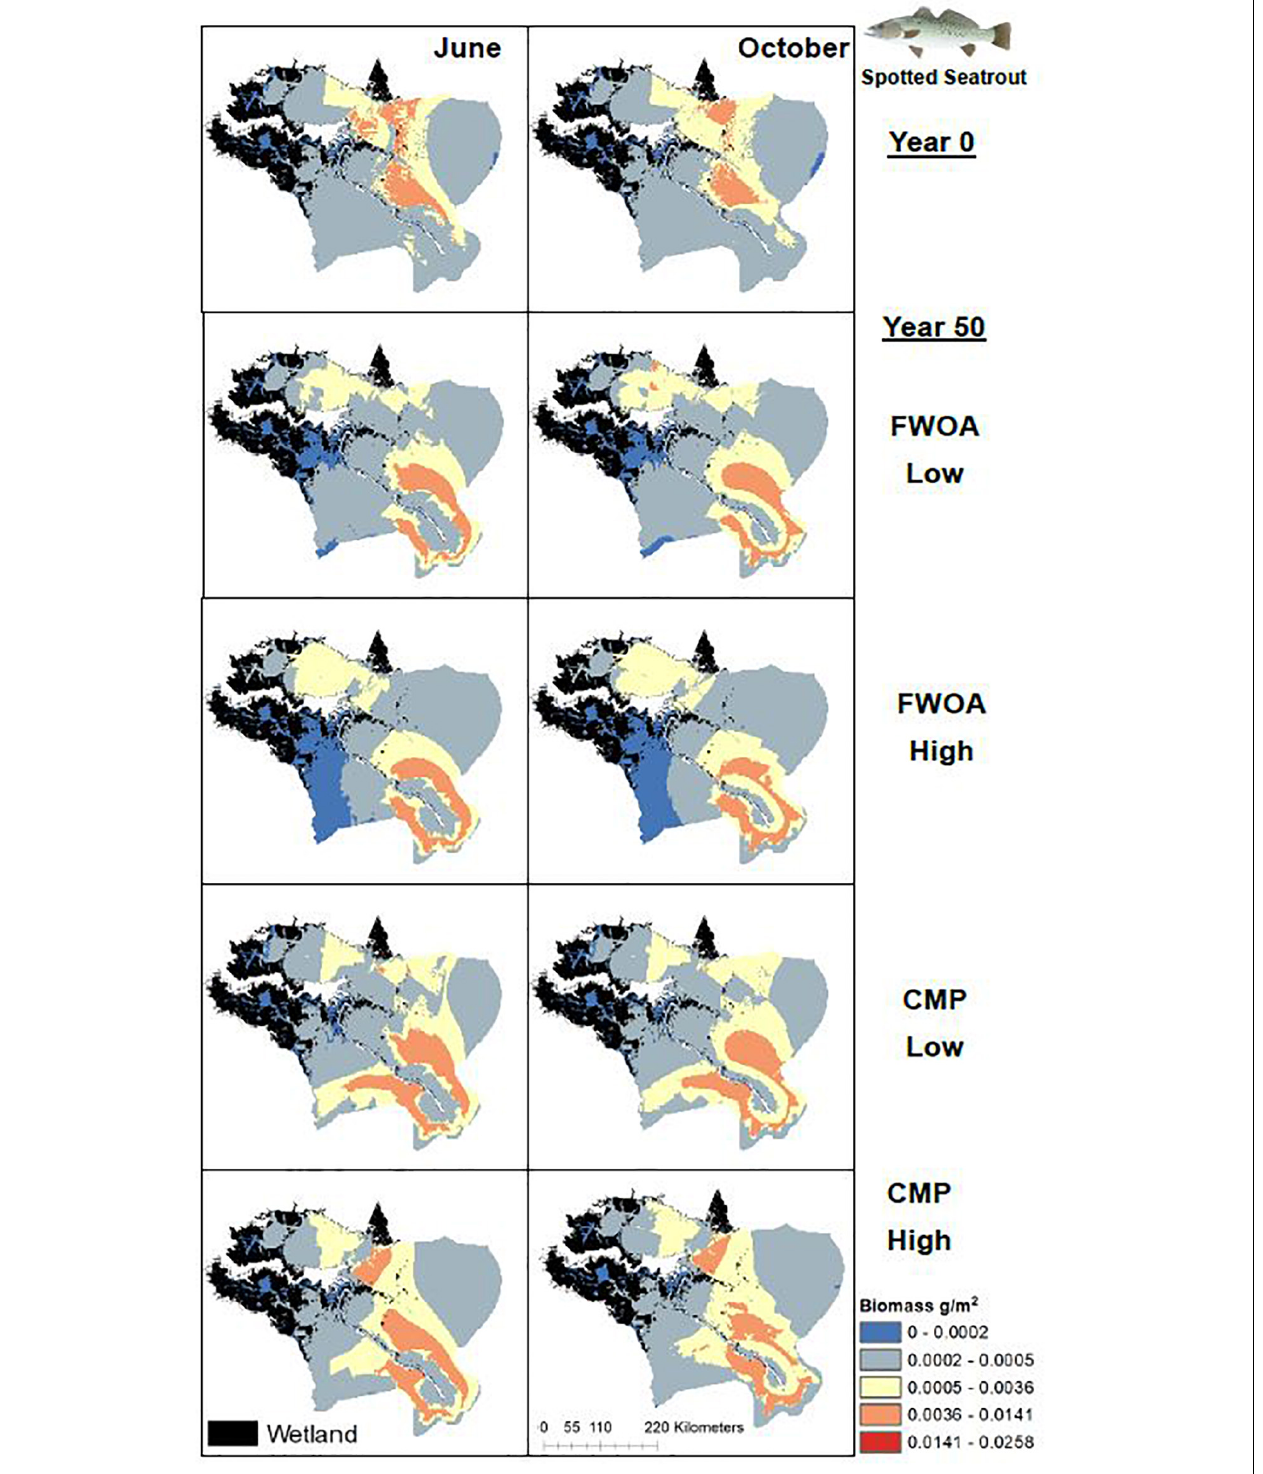
FIGURE 12 | Spatial distribution of adult Spotted Seatrout in different simulations. Output is shown from June and October in Year 0 and Year 50, under “Low” and “High” relative sea level rise (see Supplementary Table S6 for scenarios), and with Coastal Master Plan (CMP) implementation and without (FWOA).